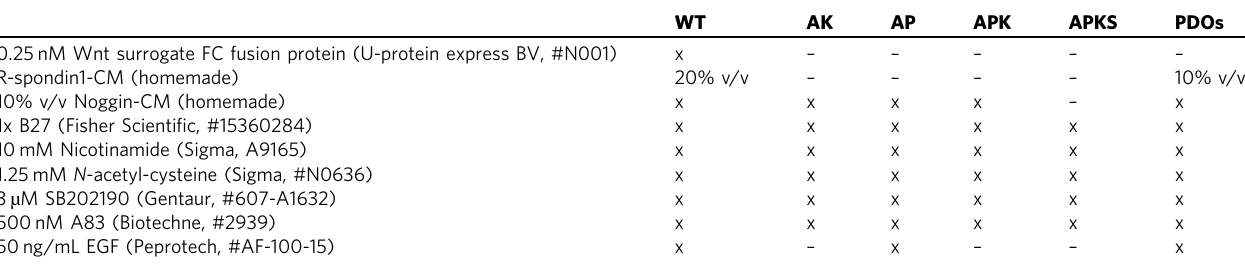
Table 2 Expansion medium composition for tumor progression organoids and patient-derived organoids